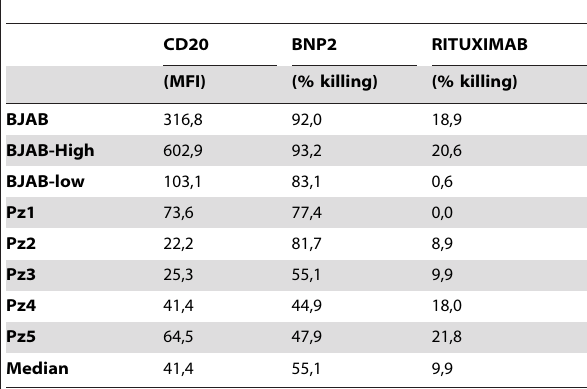
Table 1. Comparison between BNP2 and Rituximab effects.